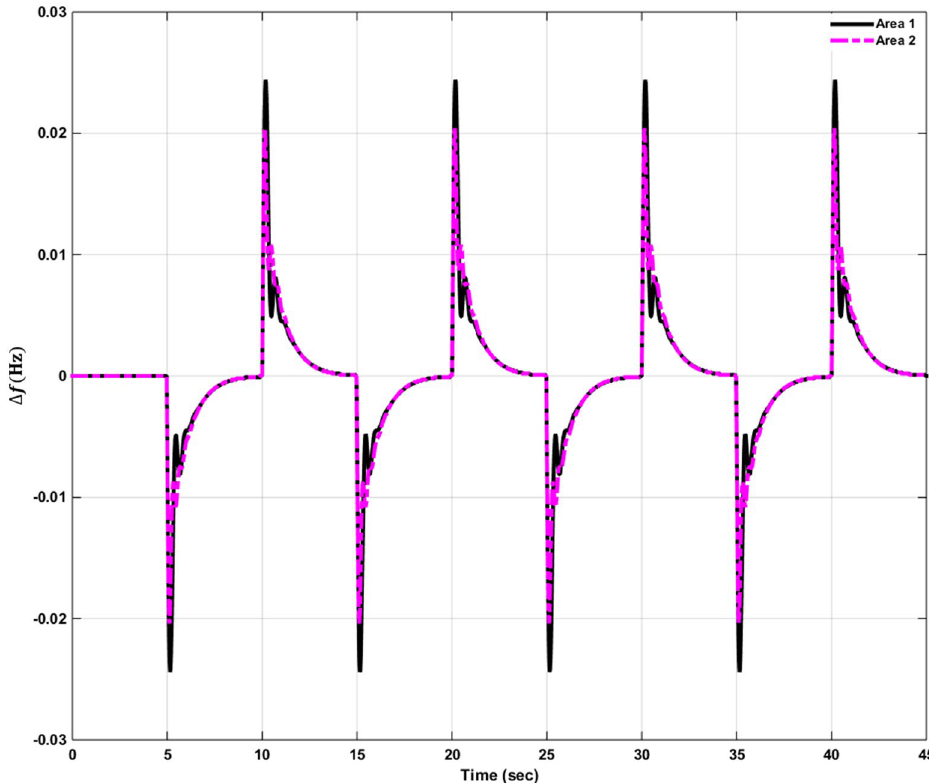
Figure 16. Frequency deviation results of two areas 1 and 2 with simultaneous SLPs.